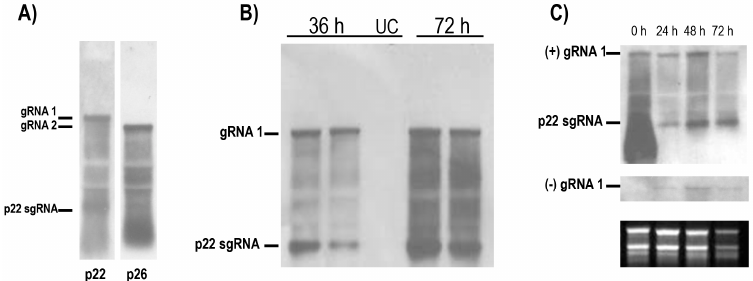
Figure 1. CYSDV RNA1 replicates independently of RNA2 in cucumber protoplasts. Positive and negative strand accumulation occurs with similar kinetics, but with quantitative asymmetry. ( A ) Northern blots of total RNA extracted from field samples of naturally CYSDV infected cucumber plants showing gRNA and positive co-terminal RNA species hybridising with a ( − ) sense p22 probe (left panel, RNA1), and a ( − ) sense p26 probe (right panel, RNA2). The position of the sgRNA for CYSDV p22 is indicated; ( B ) Northern blot of total RNA extracted 36 h and 72 h p.i. from protoplasts transfected in conjunction with CYSDV RNA1, hybridised with a ( − ) sense p22 probe. UC = uninfected control; ( C ) Time course of RNA1 transfected protoplasts hybridised with ( − ) and (+) sense probes. Duplicate northern blots were hybridised with dig-labelled riboprobes corresponding to the ( − ) sense (top panel) and (+) sense (middle panel) of the CYSDV p22 gene. The lower panel shows the EtBr stained loading controls. The positions of the gRNA bands and the p22 sgRNA are indicated.